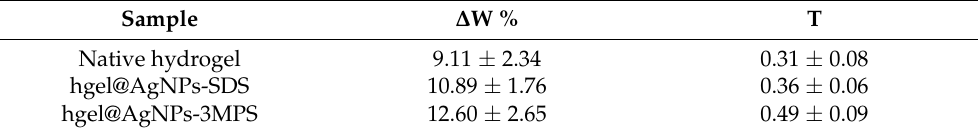
Table 1. Percentage of weight loss ( ∆ W %) after 30 days of incubation in Ringer solution and daily degradation rate (T) of native and composite